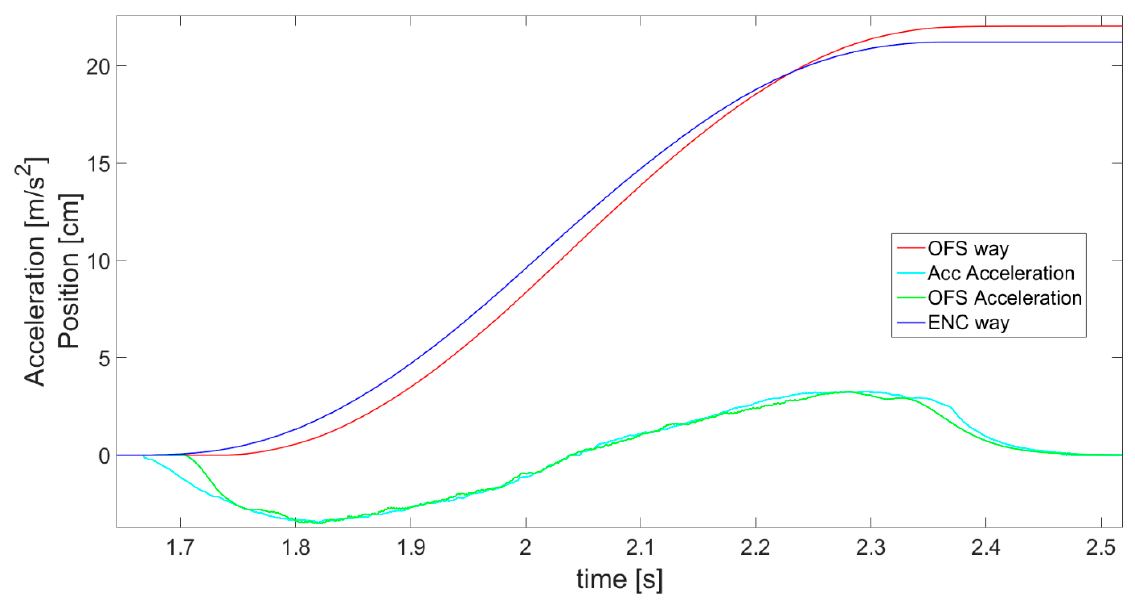
Figure 17. Magnification of part of Figure 16, showing complementary filter operation principles presented with accelerations of both sensors.